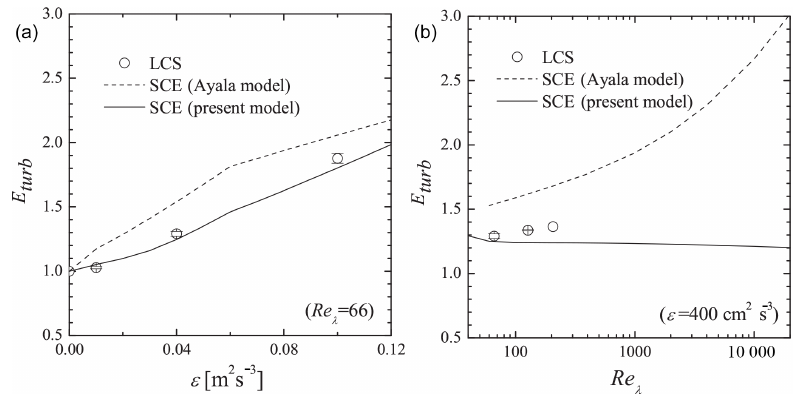
Figure 9. Turbulence enhancement factors for r c = 10µm as a function of (a) the energy dissipation rate (cid:15) and (b) the Taylor-microscale- based Reynolds number Re λ . Re λ = 66 in (a) and (cid:15) = 400cm 2 s − 3 in (b) . The error bars indicate the standard